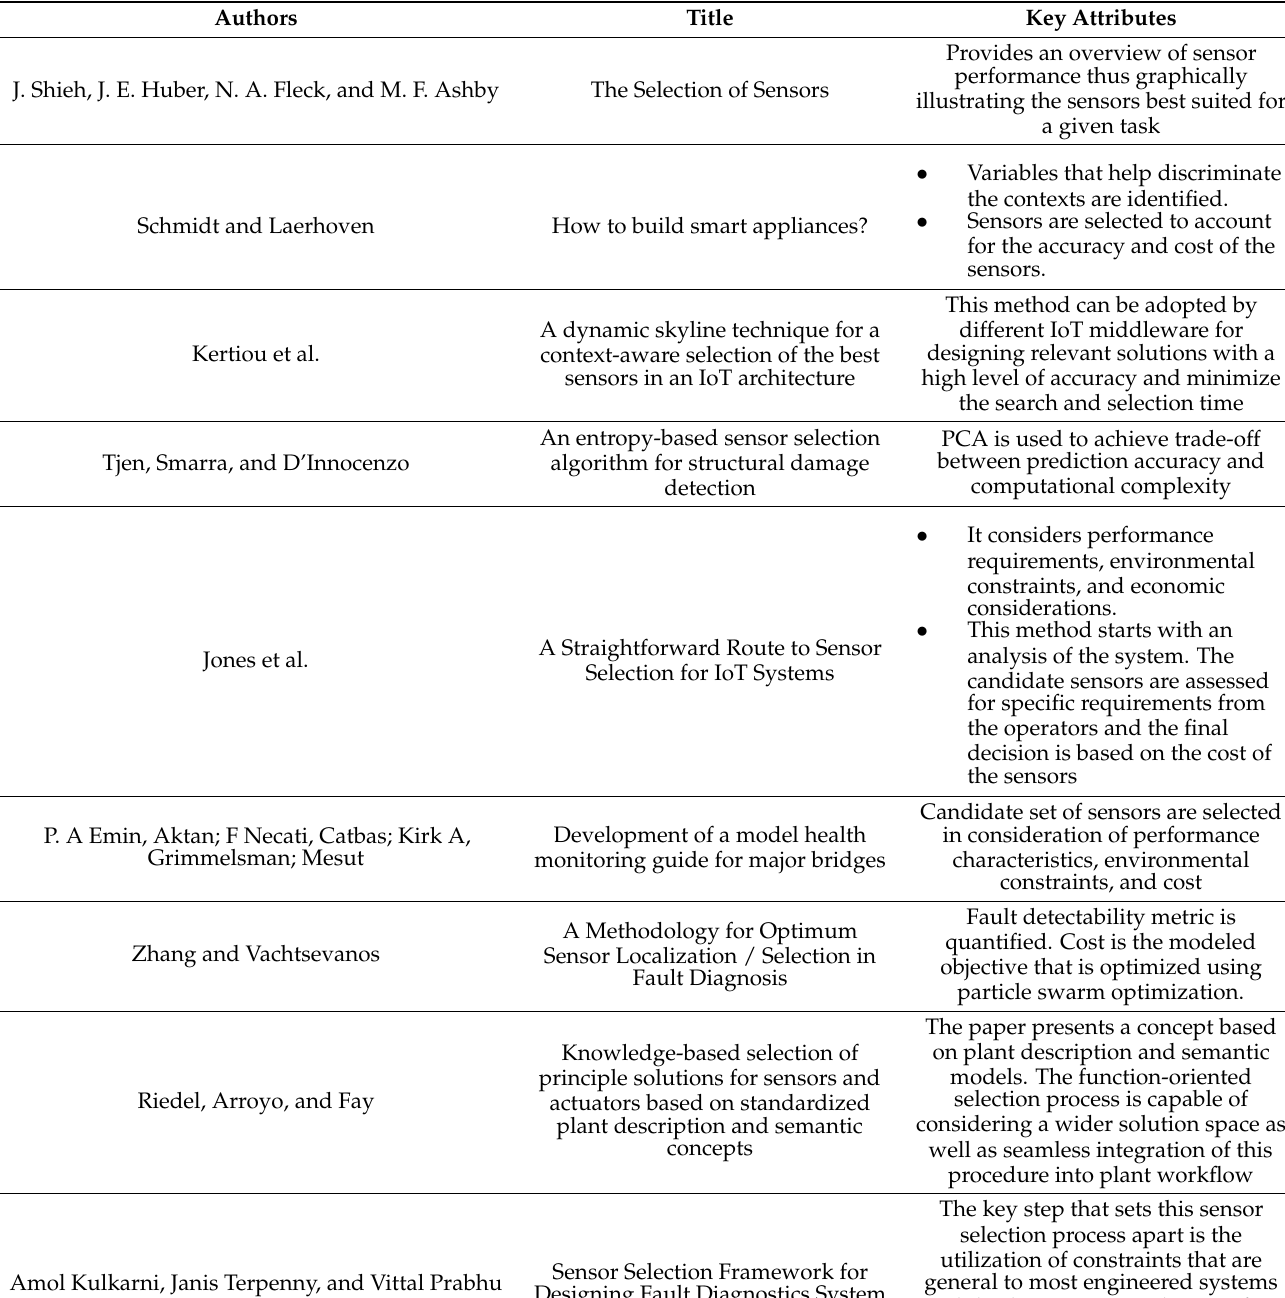
Table 1. Summary of Literature